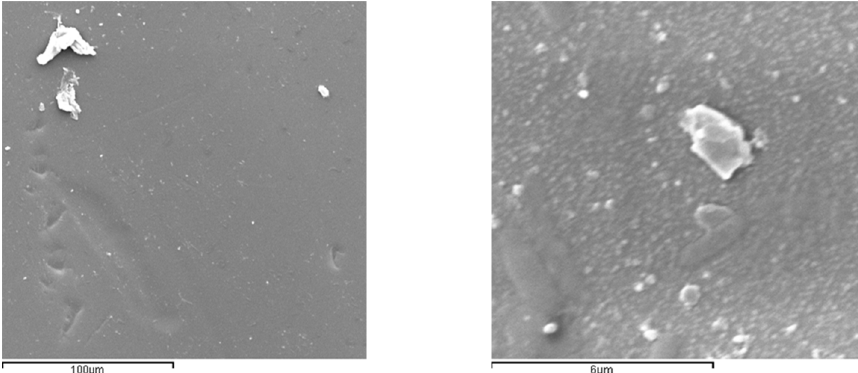
Figure 10. SEM Images for the fouled M3 membrane after the concentration mode test. Left : 100 µ m. Right : 6 µ m.